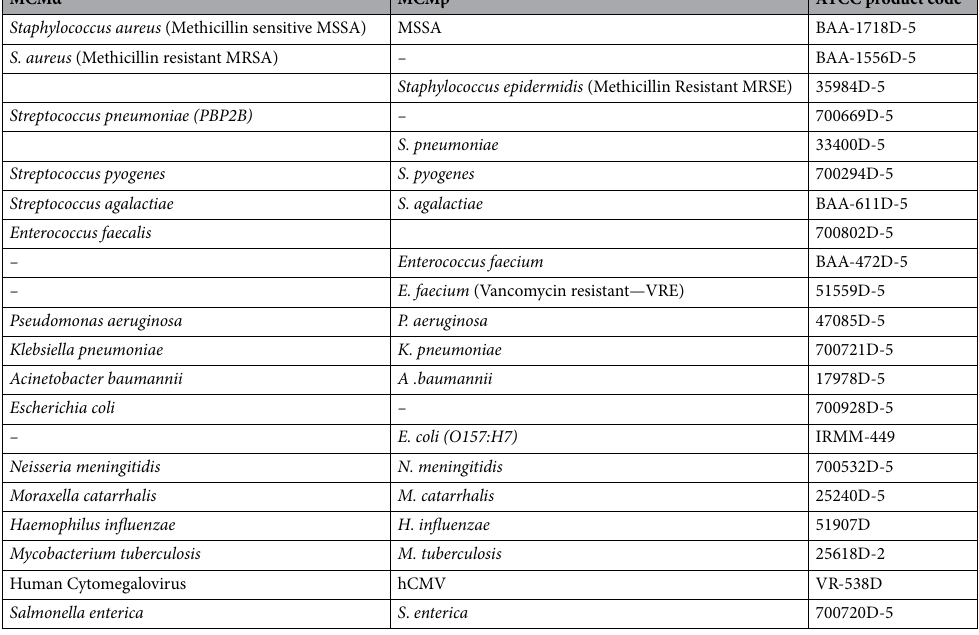
Table 1. The composition of the MCM2α and